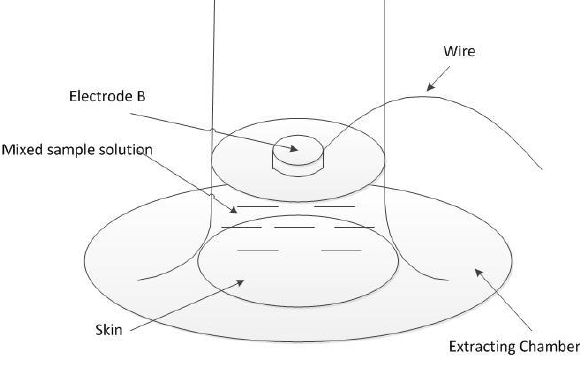
Figure 4. Electrode used for the dynamic measurement of skin